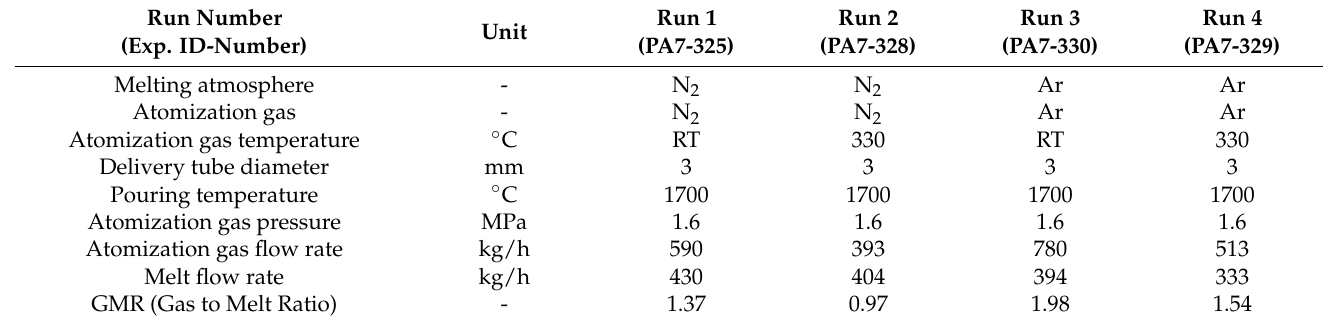
Table 2. Gas atomization parameters of the super duplex stainless steel X2CrNiMoCuWN25-7-4. Run Number (Exp.